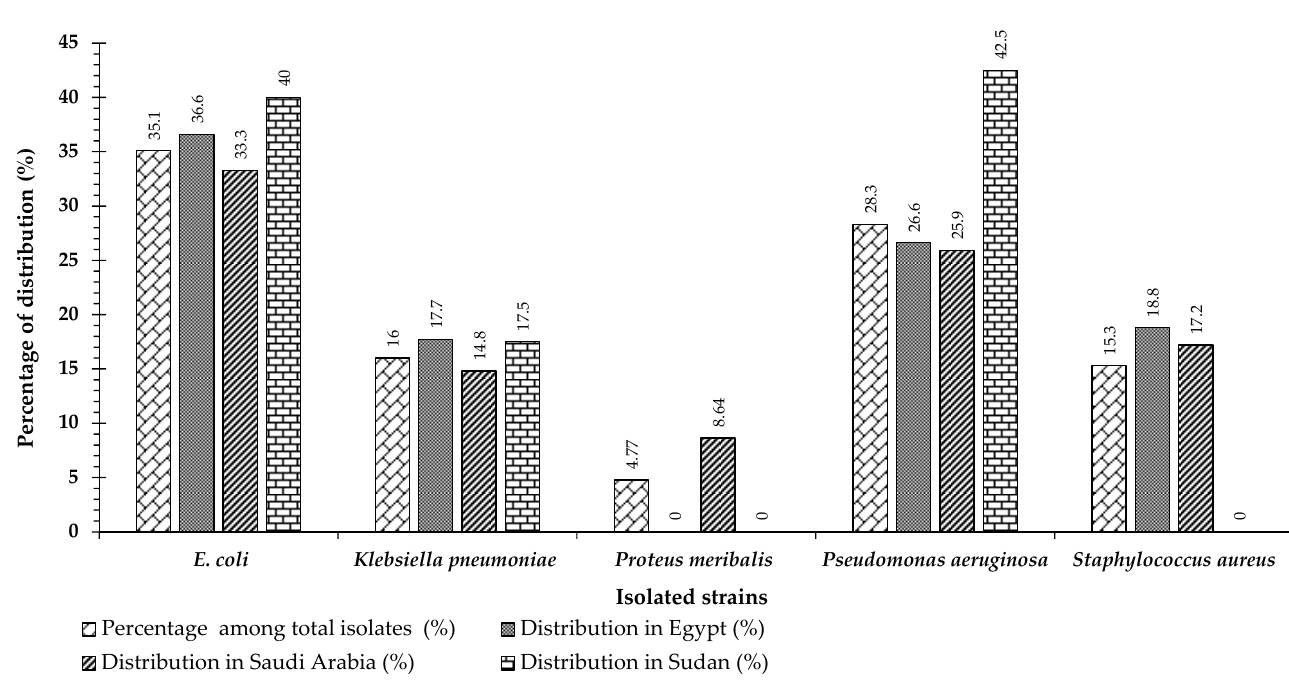
Figure 1. Percentages of pathogenic strains isolated from various clinical samples (collected from three different countries: Egypt, Saudi Arabia, and Sudan) among all isolates identified and the distribution of strains in each country (modified from Azab et al., [15]).